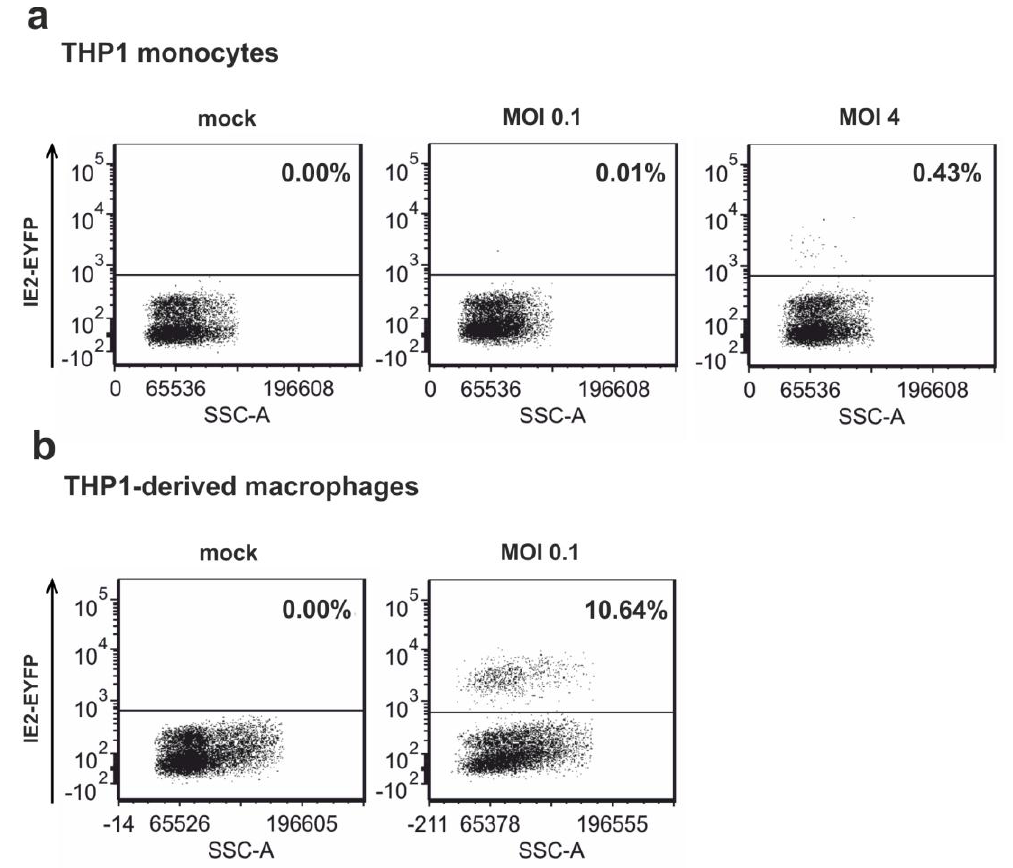
Figure 5. HCMV infection of THP-1 cells results in a quiescent state with almost